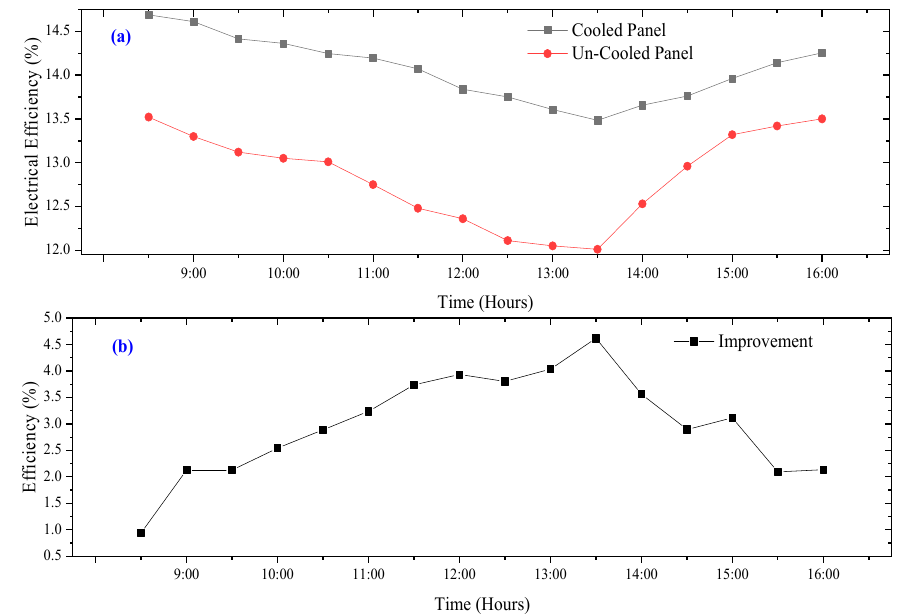
Figure 14. Time dependence ( a ) electrical efficiency ( b ) improvement in efficiency.